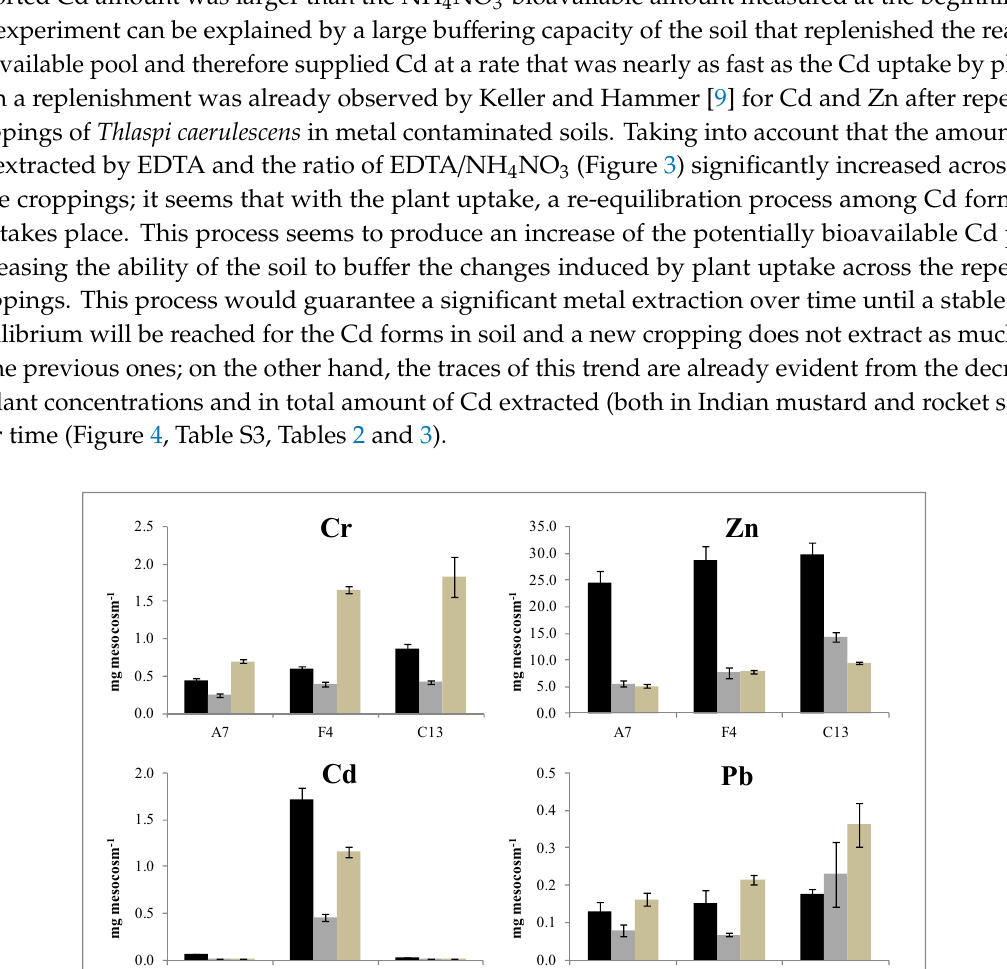
Figure 5. Projection of Cd concentration in Rocket salad (on the average of the year) in relation to the number of phytoextraction cycles by Indian mustard. 4. Conclusions The results of this work show that three consecutive croppings of Brassica juncea on polluted soils, from an agricultural area under sequestration for illegal dumping of industrial sludge, can achieve a significant reduction of the bioavailable metal concentrations in soil along with changes of the soil pH and equilibrium between PTEs pools. In the studied soils, PTE bioavailability was negatively correlated with pH and, according to single chemical extractions, Cd and Zn were more mobile and bioavailable than Cr and Pb. The different bioavailability was reflected by the PTEs uptake of Indian mustard plants extracting from soil and translocating from roots to shoots higher amounts of Zn and Cd than of Cr and Pb. PTEs extraction by repeated croppings of Indian mustard changed across experimental years as a result of associated modification of soil properties due to the plant growth. This observation highlights that bioavailability in soil-plant systems is a dynamic concept changing with soil, plant